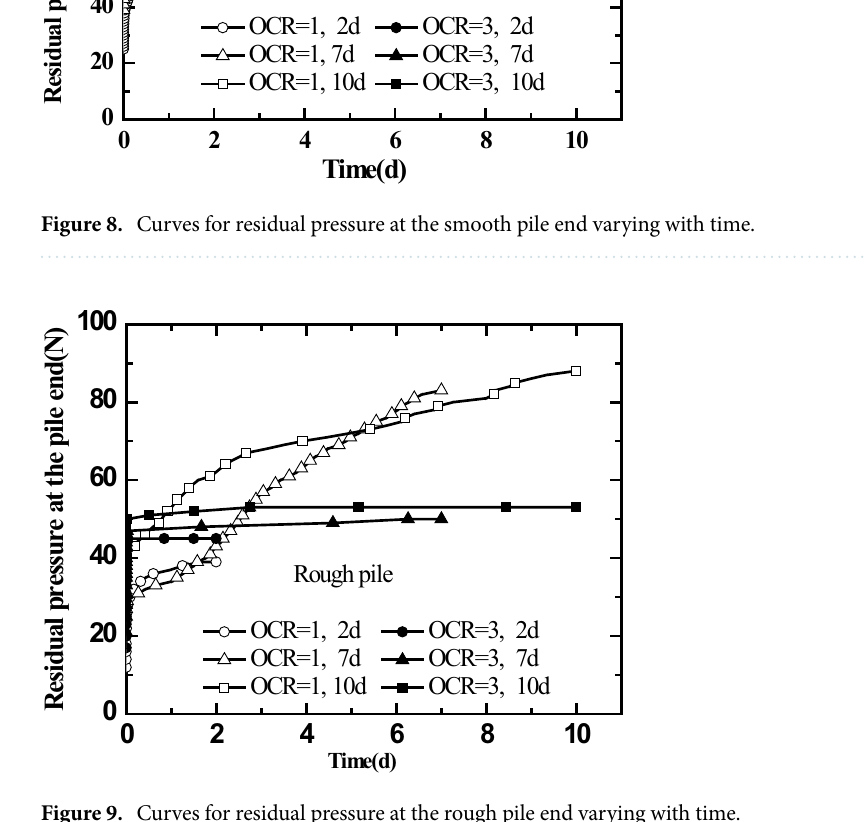
Figure 9. Curves for residual pressure at the rough pile end varying with